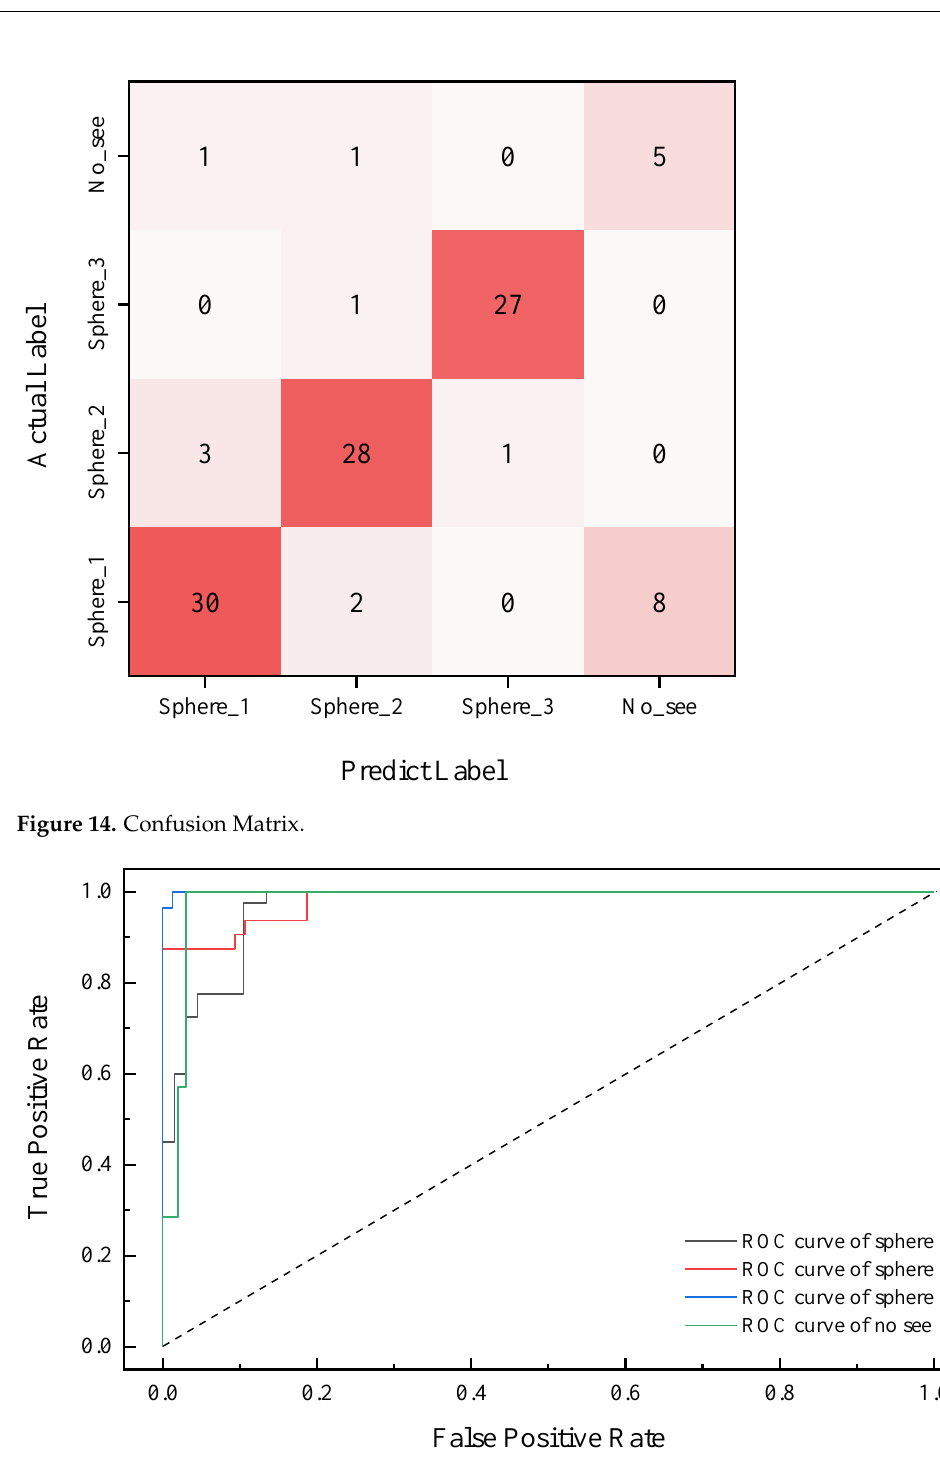
Figure 15. Receiver operating characteristic classification diagram.